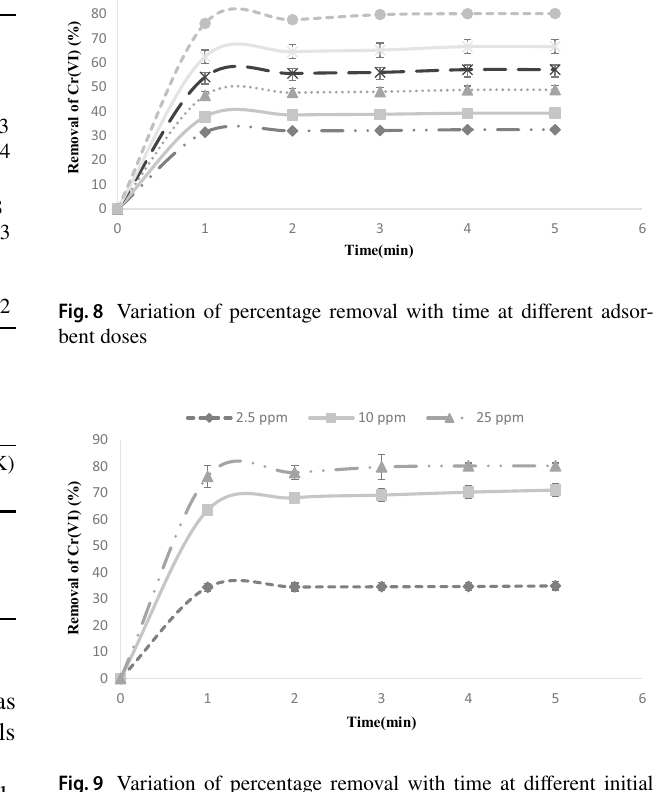
Fig. 9 Variation of percentage removal with time at different initial